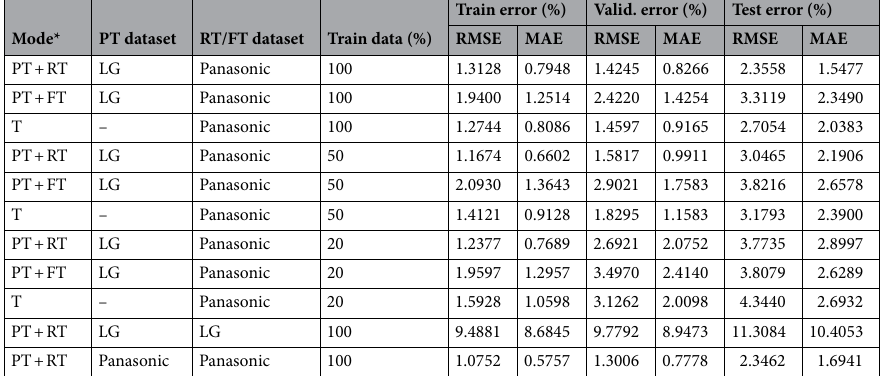
Table 4. Cross dataset performance. * PT Pre-training, RT Re-training, FT Fine-tuning, T Training.